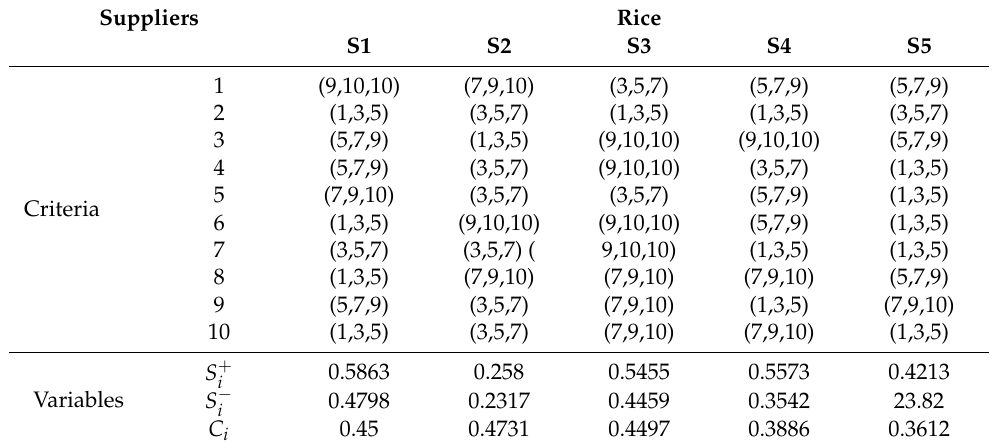
Table A17. Decision matrix considering suppliers and similarity index for rice.